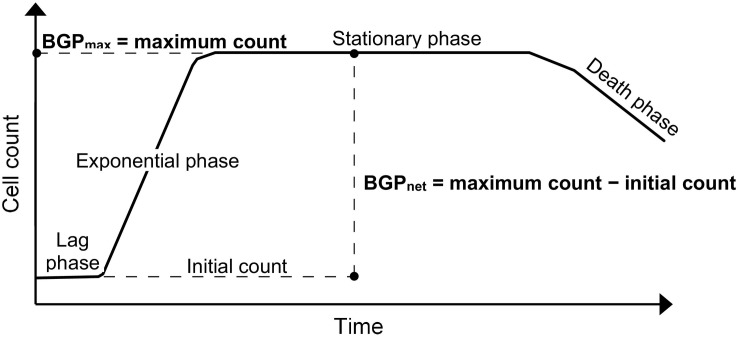
Typical bacterial growth curve illustrating the different ways of expressing bacterial growth potential (BGP) results: maximum bacterial growth(BGPmax) and net bacterial growth (BGPnet).